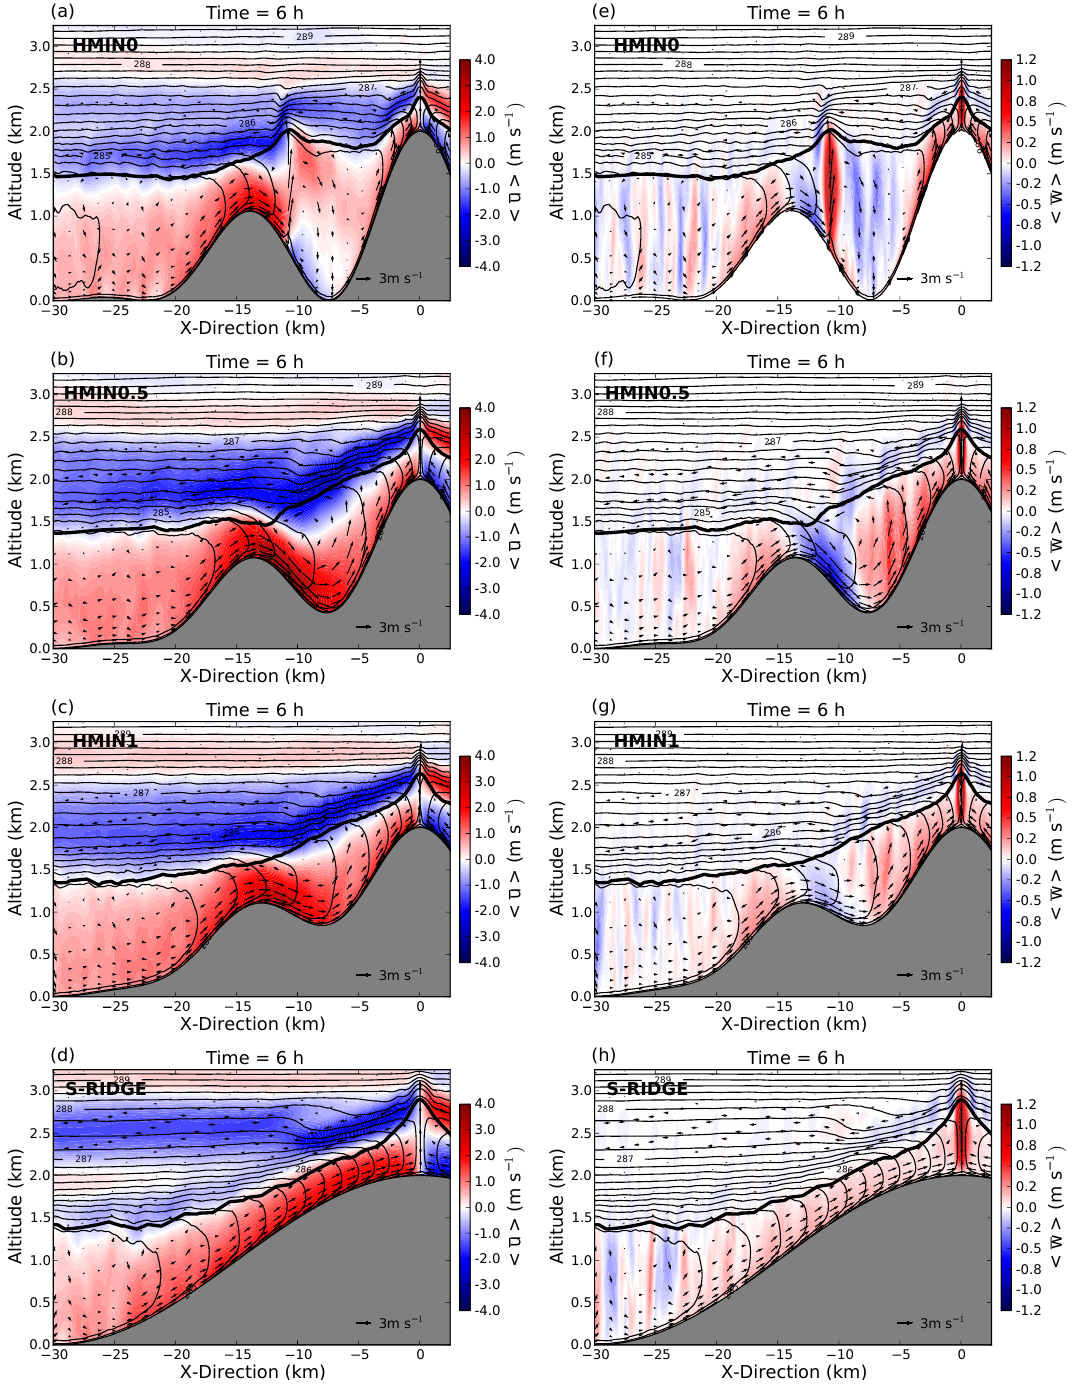
Figure 3. Cross sections of averaged (a–d) cross-mountain wind speed and (e–h) vertical wind speed as color contours after 6h of simulation for four different mountain shapes: (from top to bottom) HMIN0, HMIN0.5, HMIN1, and S-RIDGE (cf. Table 1). Potential temperature as black contour lines (0 . 25K increment) and wind vectors for components parallel to the cross section. Variables are averaged in time and space (along y direction). The black solid line shows the reference CBL height